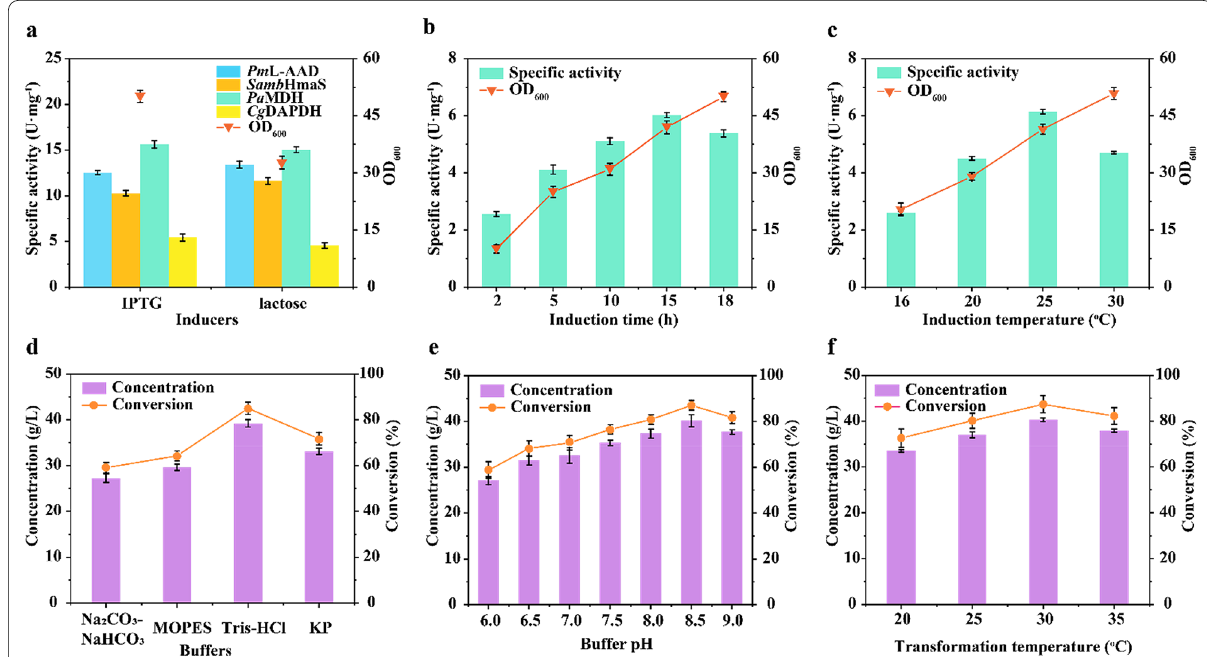
Fig. 6 Optimizations during induction and conversion process with strain E. coli 07. a Effect of inducers (IPTG and lactose) on specific activity of the four route enzymes and cell growth of E. coli 07. b Effect of induction time on Cg DAPDH BC621/D120S/W144S/I169P specific activity and cell growth. c Effect of induction temperature on Cg DAPDH BC621/D120S/W144S/I169P specific activity and cell growth. d Effect of buffer type on D-HPG concentration. e Effect of buffer pH on D-HPG concentration. f Effect of transformation temperature on D-HPG concentration. Reactions were performed in triplicate with resting cells of E. coli 07 (20 g/L wet cells) and 50 g/L l -tyrosine in 800-mL Tris–HCl buffer (20 mM, pH 8.5, 50-g/L NH 4 Cl, 0.5-mM CoSO 4 , and 0.7-mM NADP + ) at 500 rpm and 30 °C for 24 h. The conversion and titer were obtained after completion of the reactions and determined by HPLC